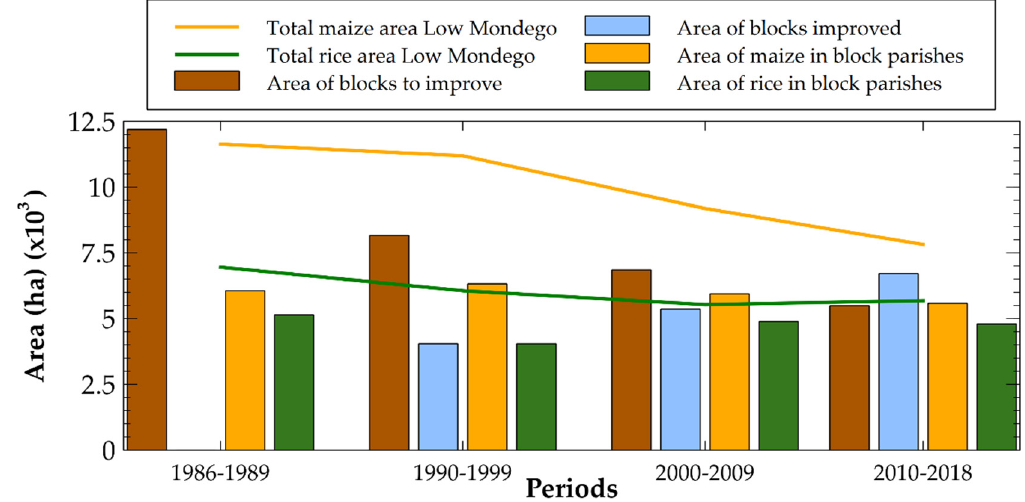
Figure 15. Total areas of maize and rice in the Low Mondego; areas of the blocks still to improve or already improved; improved areas of maize and rice in block parishes.